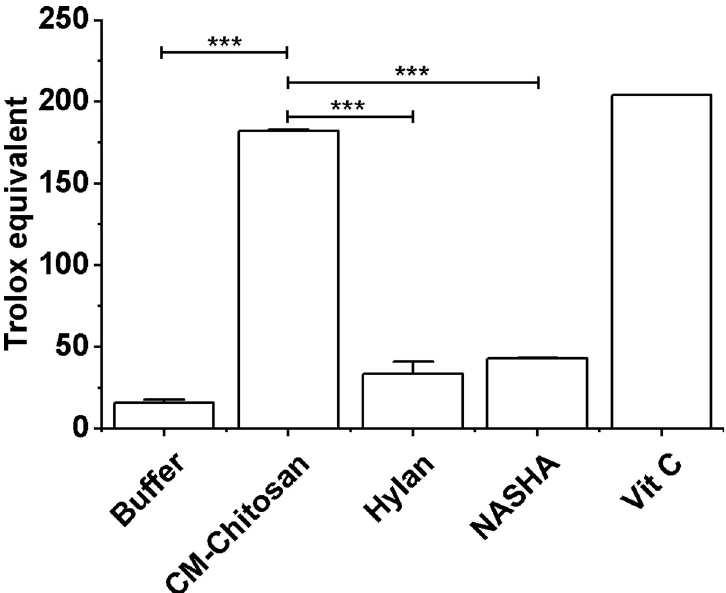
Fig 7. Free radical scavenging capacity using the TEAC assay. KiOmedine 1 CM-chitosan was compared to Hylan G-F 20, NASHA, negative and positive controls respectively, the polymer-free buffer of KiOmedine 1 CM-chitosan and vitamin C. KiOmedine 1 CM-chitosan showed high free radical scavenging capacity in vitro as compared to crosslinked HA biomaterials, Hylan G-F 20, and NASHA (ANOVA, ��� p < 0.0001).